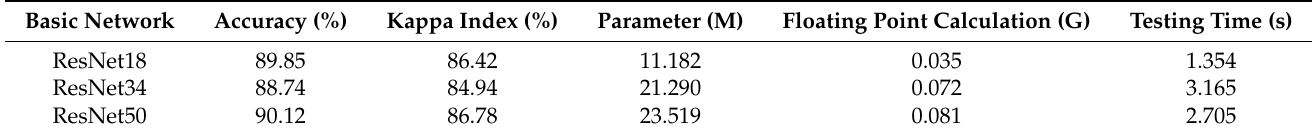
Table 1. Comparison of basic network related